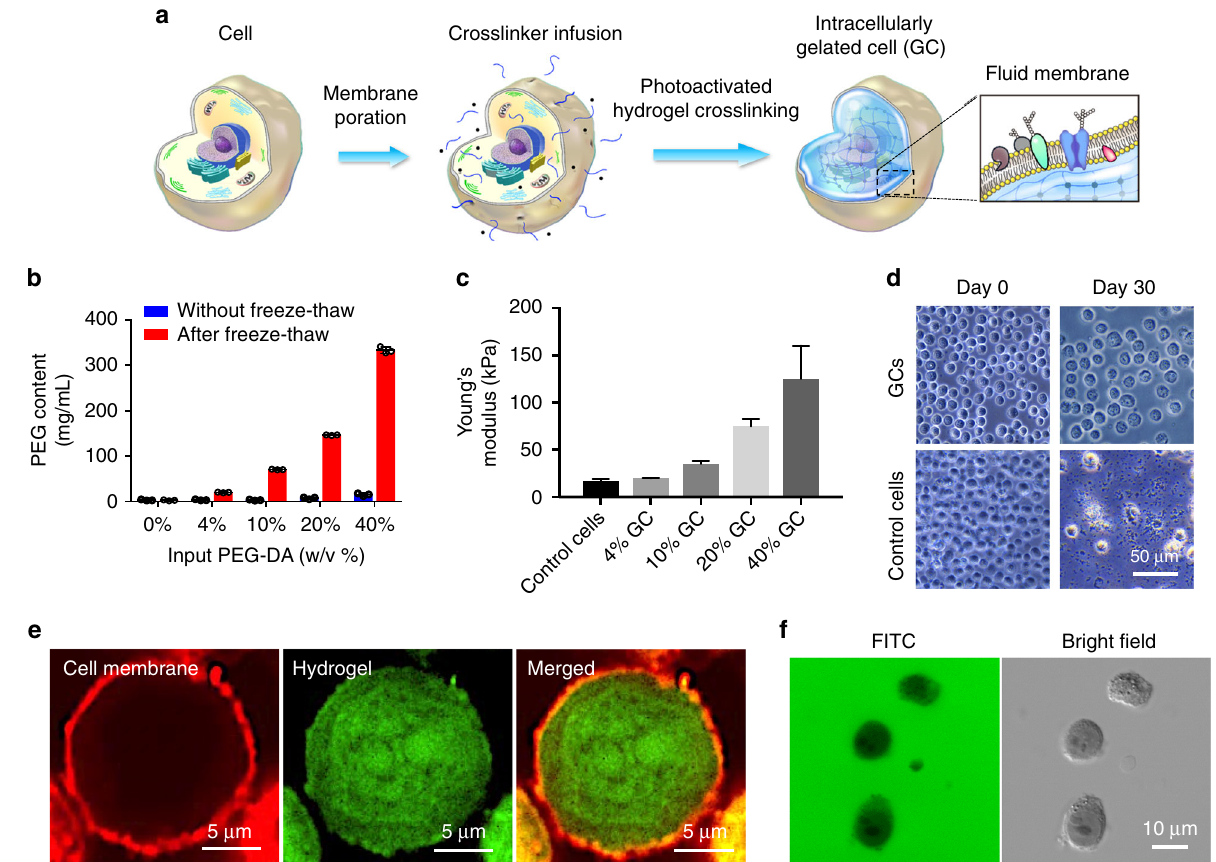
Fig. 1 Preparation and characterization of intracellularly gelated cells (GCs). a Hydrogel monomers and photoinitiators are infused into the intracellular domain of cells following transient membrane poration. UV-activated hydrogel cross-linking is then performed to stabilize the cell membrane interface. b Intracellular concentrations of PEG in cells before and after freeze – thaw treatments in gelation buffers containing different PEG-DA content. Error bars represent mean ± standard deviation, n = 3. c The Young ’ s moduli of the GCs prepared with different concentrations of hydrogel monomers were measured by atomic force microscopy. Error bars represent mean ± standard deviation, n = 64. d Bright- fi eld microscopy of 4 wt% GCs and control cells suspended in PBS for 0 and 30 days. Scale bar = 50 μ m. e Structure of 20 wt% GCs was visualized with fl uorescein-diacrylate (green) for hydrogel labeling and DiD dye (red) for membrane staining. Scale bars = 5 μ m. f 4 wt% GCs suspended in fl uorescein solution showed that the GCs were impermeable to the